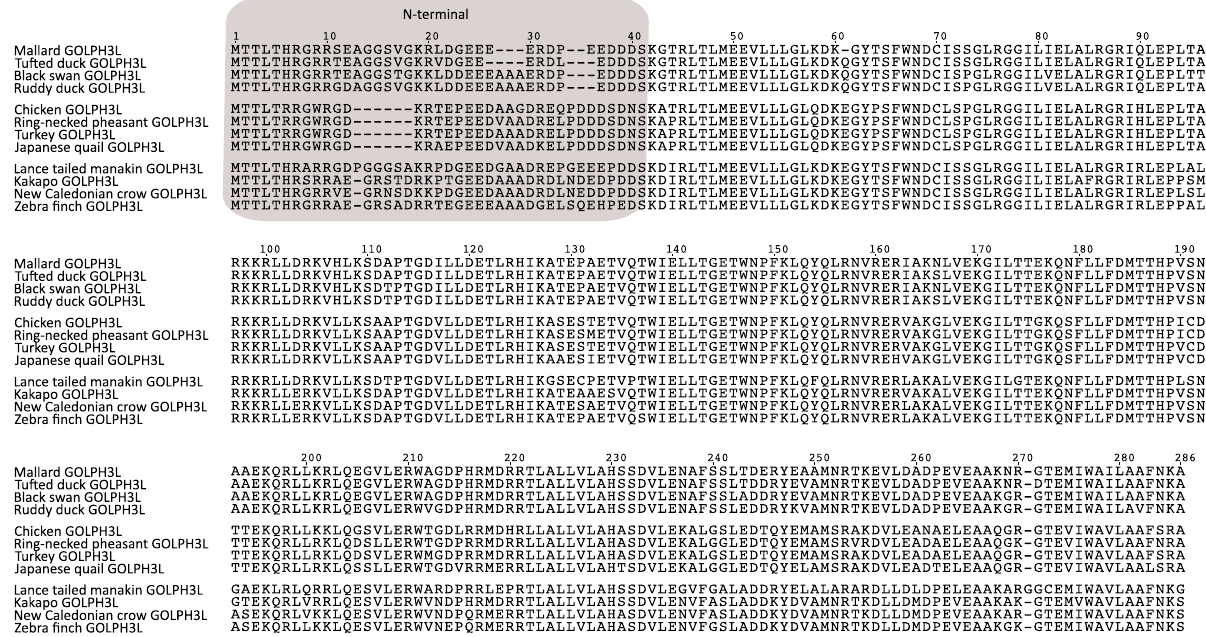
Figure 8. Alignment of Golgi phosphoprotein 3L (GOLPH3L) amino acid sequences from mallard ( Anas platyrhynchos ), Tufted duck ( Aythya fuligula) , black swan ( Cygnus atratus ), ruddy duck ( Oxyura jamaicensis ), chicken ( Gallus gallus ), ring-necked pheasant ( Phasianus colchicus) , turkey ( Meleagris gallopavo ), japanese quail ( Coturnix japonica ), lance tailed manakin ( Chiroxiphia lanceolata ), kakapo ( Strigops habroptilus ), New caledonian crow ( Corvus moneduloides ) and zebra finch ( Taeniopygia guttata ). The N-terminal region of the protein is